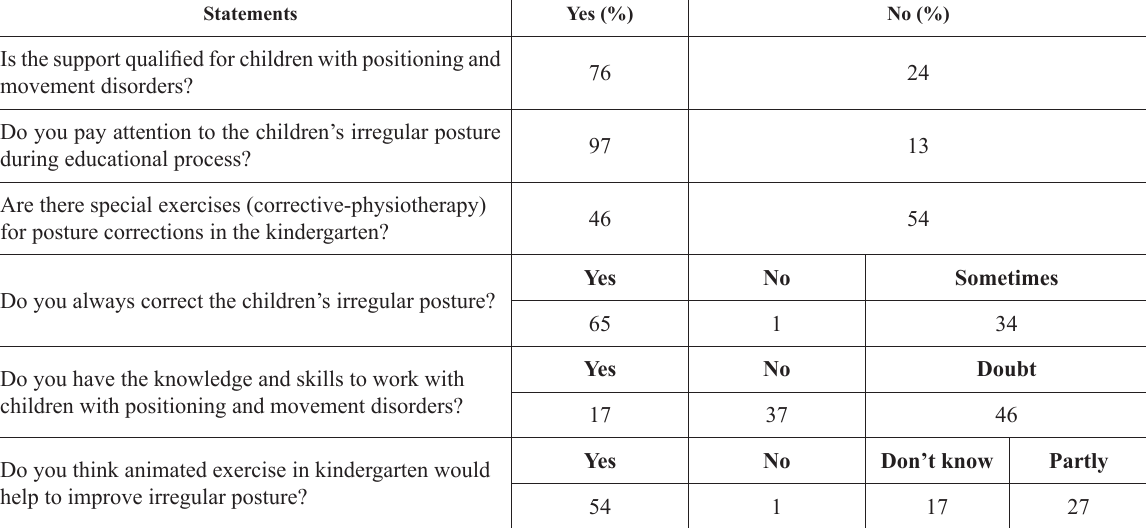
Table 2. Percentage distribution of educators and administration identifying the need for play programs in the educational